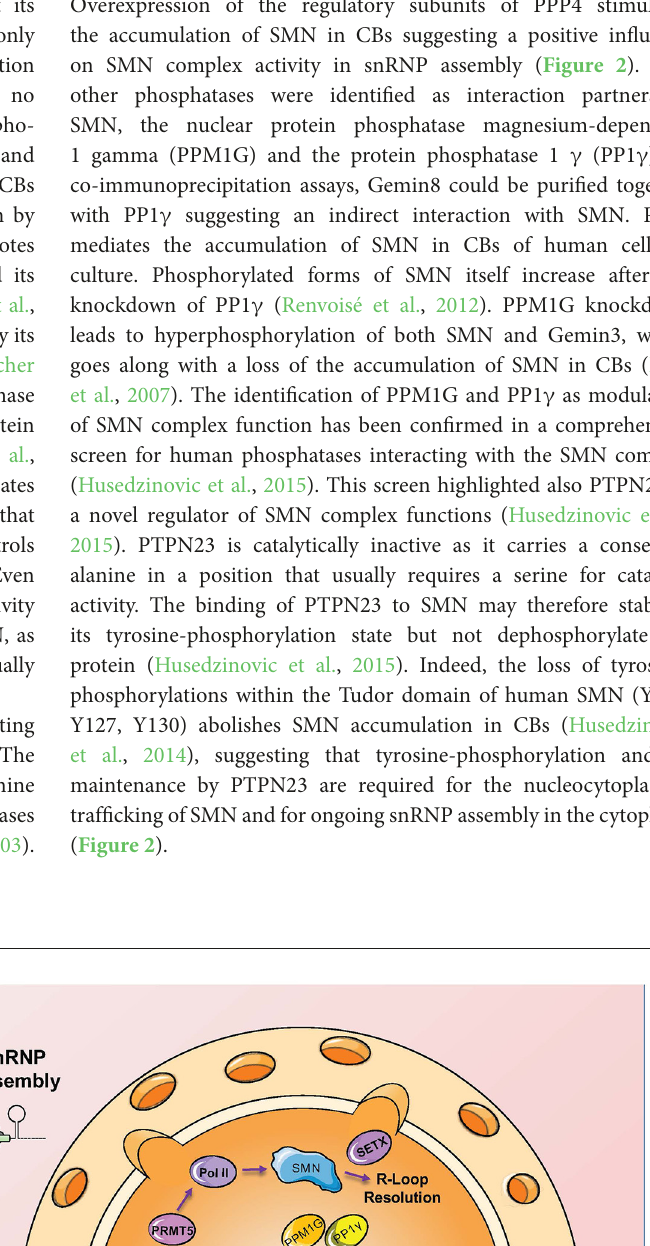
Frontiers in Cellular